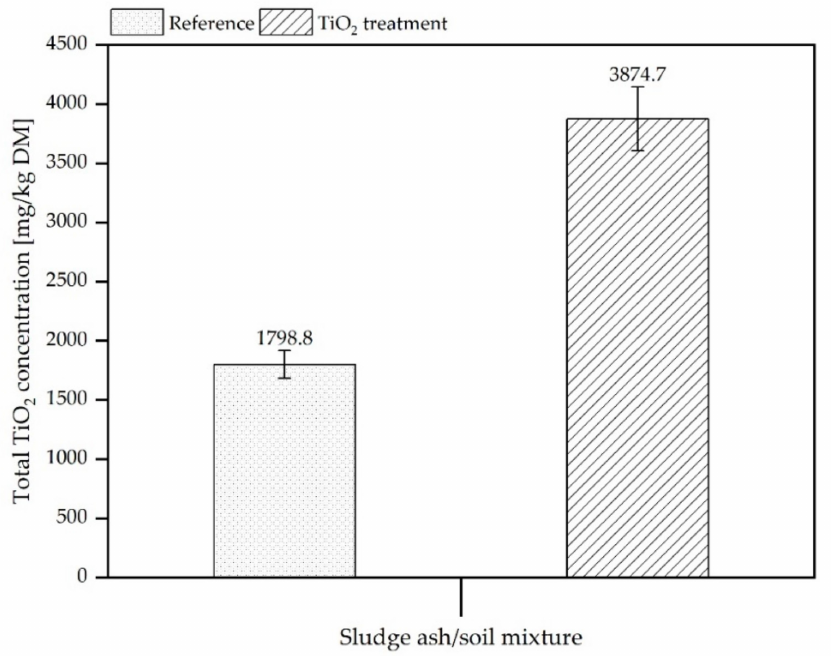
Figure 2. Total TiO 2 concentrations (converted Ti-concentrations) in sludge ash/soil mixtures. left column: Concentration in samples using sludge ash without treatment with nTiO 2 , right column: Concentration in samples using SSA treated with nTiO 2 . Error bars refer to standard deviation of four subsamples that were digested and